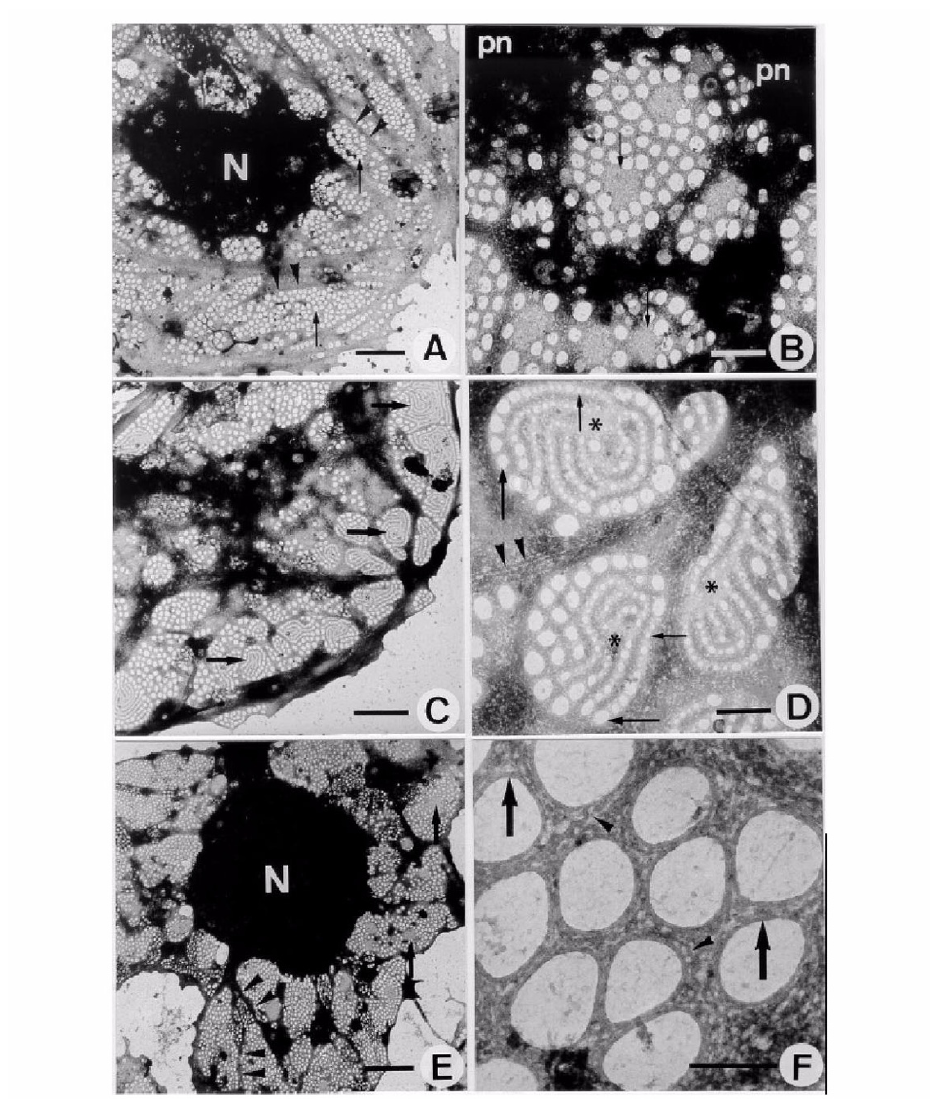
Figure 7 TEM micrographs of whole mount, formaldehyde prefixed, cytoskeleton buffer-extracted control LSEC (A), and di-h-HALI treated LSECs (B-F). ( A ) Low magnification showing the area containing the nucleus (N) and extracted cytoplasm. Note that the sieve plates are well defined by a dark border (arrowheads). Inside the sieve plates, fenestrae can be observed (small arrows). Scale bar, 2 µ m. ( B ) Treatment with di-h-HALI for 10 to 20 minutes resulted in the appearance of small cytoplasmic unfenestrated areas of intermediate density (small arrows) lying in the neighbourhood of the perinuclear area (pn). Scale bar, 1 µ m. ( C ) Within 30–60 minutes of treatment, small cytoplasmic unfenestrated areas of intermediate density (arrows) could be observed within the peripheral cytoplasm. Scale bar, 2 µ m. ( D ) Examination at high magnification of such cytoplasmic unfenestrated area or FFC (asterisks) show a peculiar structure, with centrally very small fenestrae (small arrow) which form rows of fenestrae with increasing size (large arrow), radiating into the surrounding cytoplasm as a whirlwind. Note the presence of microtubule bundles closely running along the sieve plates (arrowheads). Scale bar, 1 µ m. ( E ) Low magnifica- tion showing the cell nucleus (N) and the highly fenestrated cytoplasm (small arrow) after 120 minutes of di-h-HALI treatment. Note the thin cytoplasmic arms (arrowheads) which run from the nucleus into the cytoplasm. Inactive FFCs (arrows). Scale bar, 5 µ m. ( F ) Higher magnification of the fenestrated cytoplasm shows the presence of FACRs (arrow). From these rings, small interconnecting filaments (arrowheads) seem to cross-link the surrounding cytoskeleton. Scale bar, 250